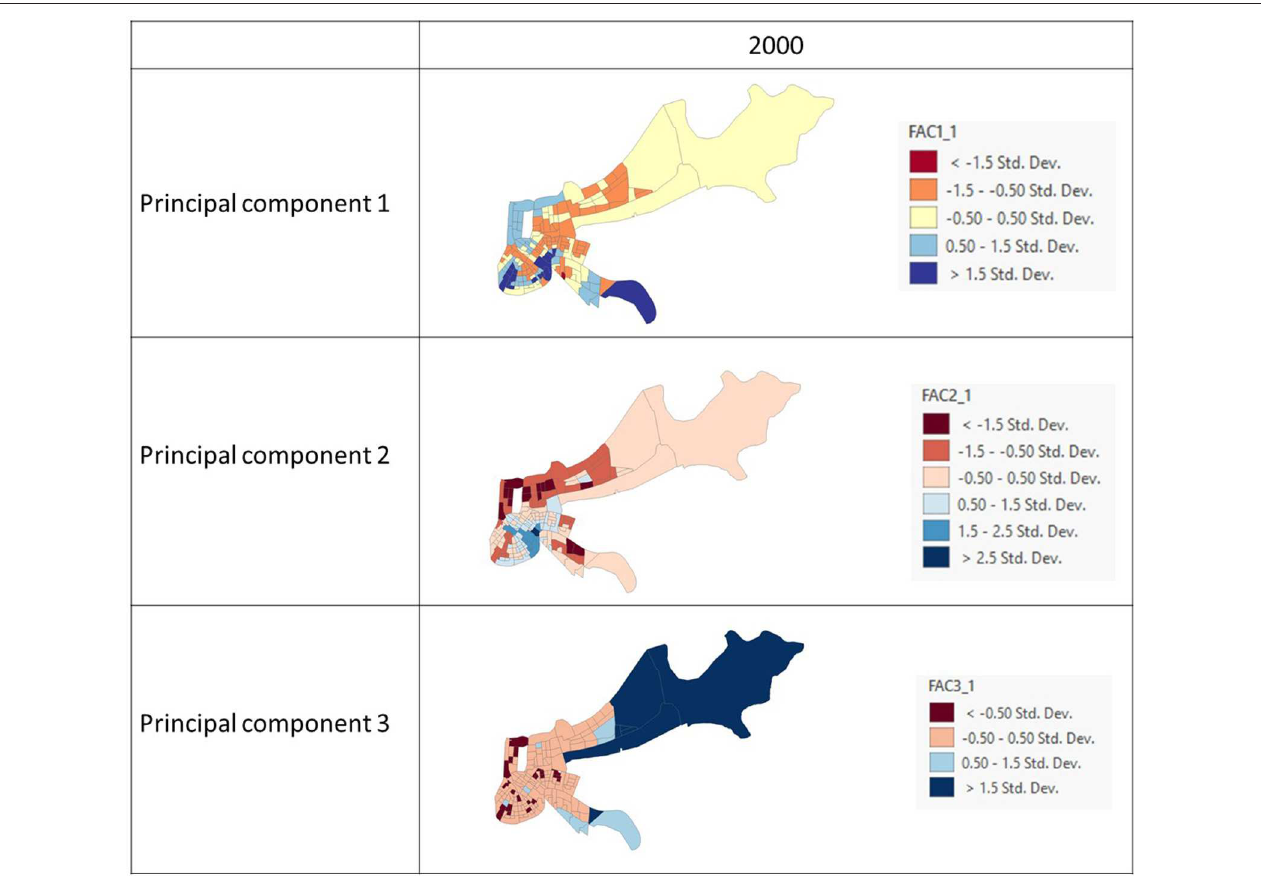
FIGURE 5 | First three principal components for 2000. Classified by standard